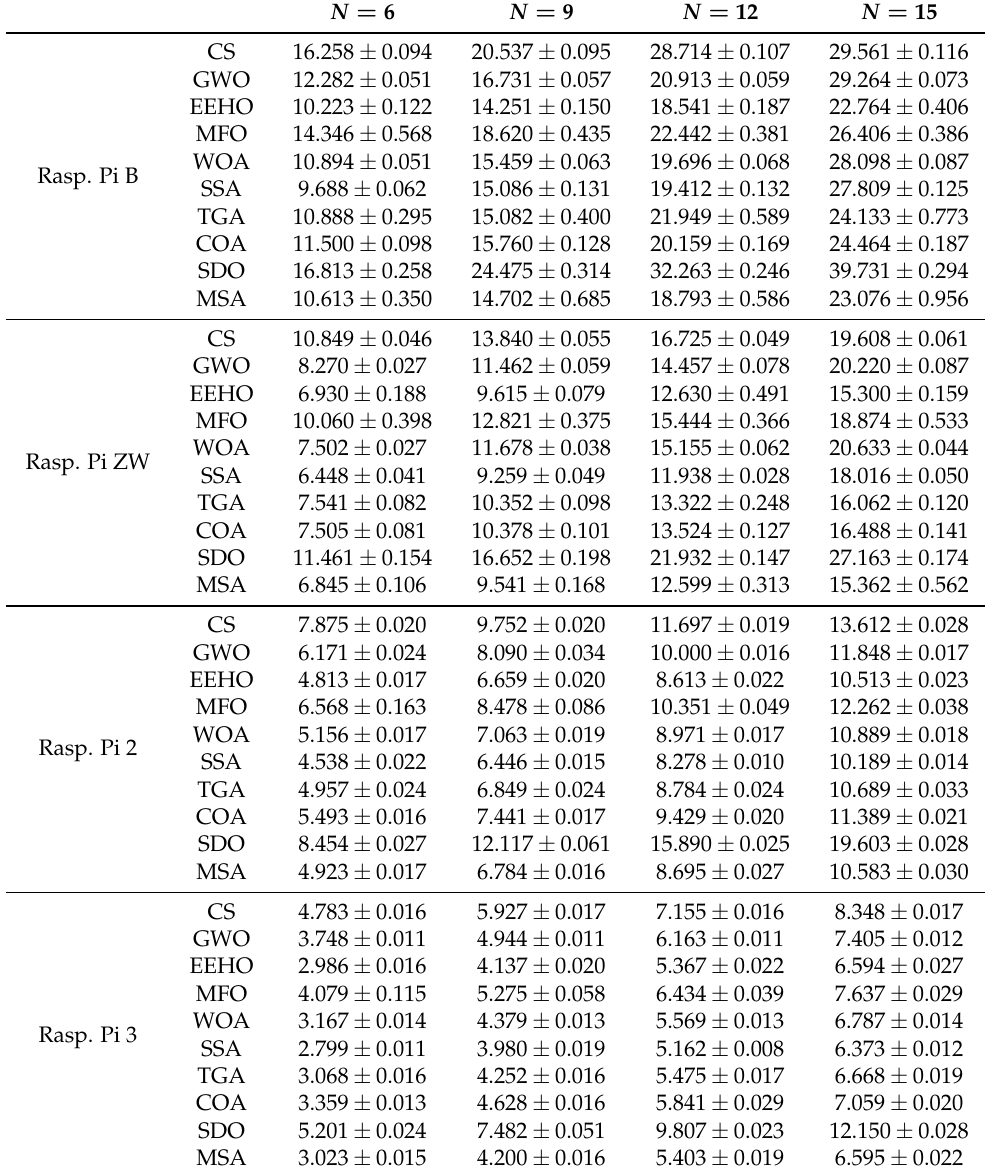
Table 9. Average execution time (¯ t ) ± standard deviation ( σ t ) to reach 1000 function evaluations (in